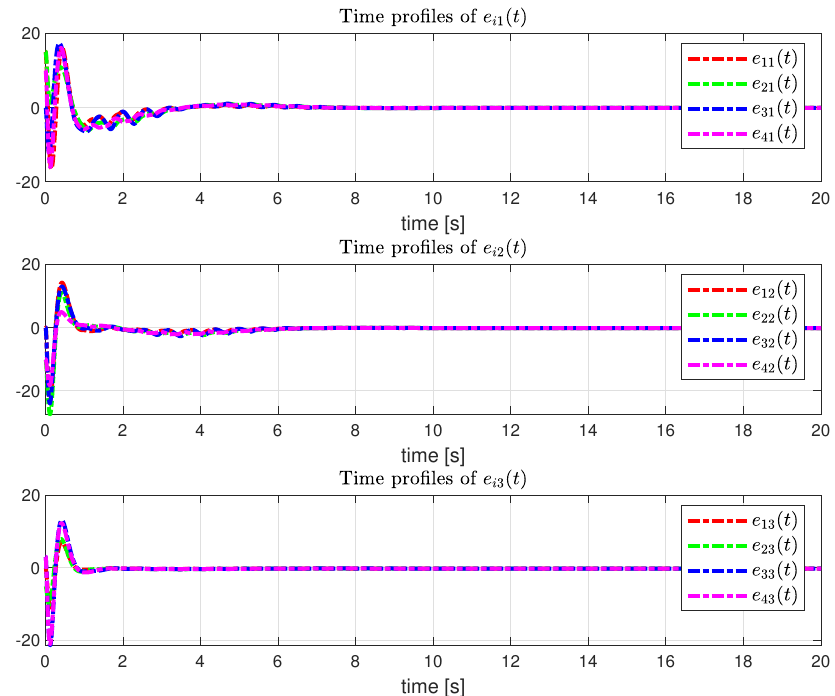
Figure 11. Performance of the control method in [29] under communication network ¯ T c = 0.3 s.